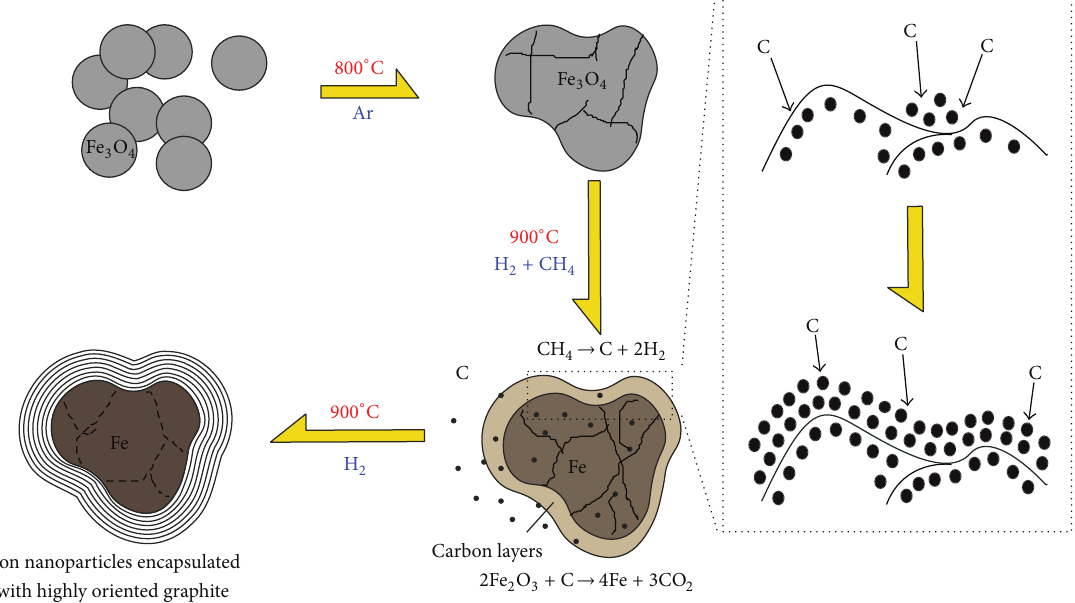
Figure 4: Assumed development of GFeNps: At 800 ∘ C, smaller magnetite nanoparticles coalesce into a larger polycrystalline one under Ar atmosphere. At 900 ∘ C, hydrogen reacts with methane to produce carbon and carbon-hydrogen derived species, which impinge on the partially melted iron surface to form a thin carbon-rich iron surface. After reaching the carbon supersaturation, graphene nucleates at the grain boundaries and then it conformally grows to completely coat the particle surface.